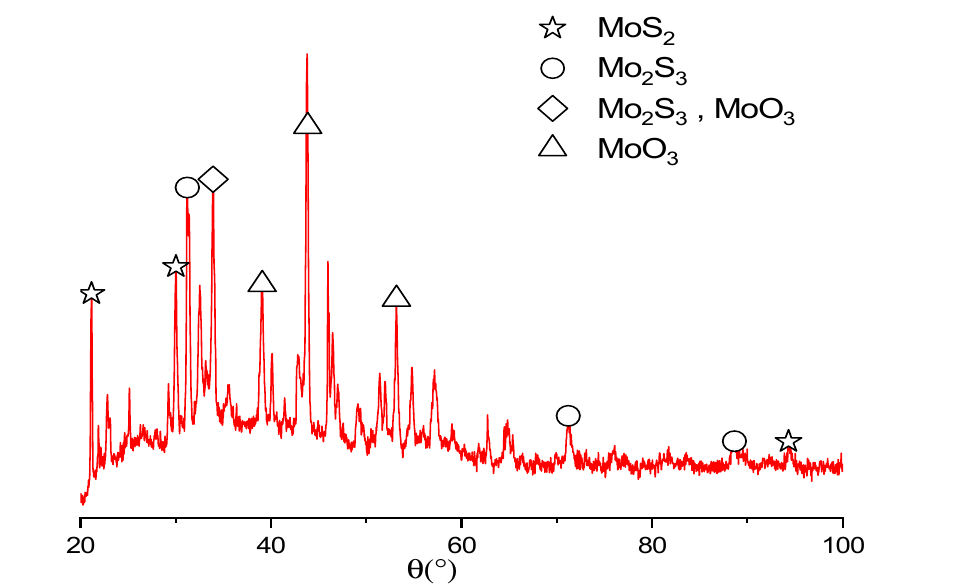
Figure 6. XRPD of the obtained Mo-based catalyst after thermal processing.